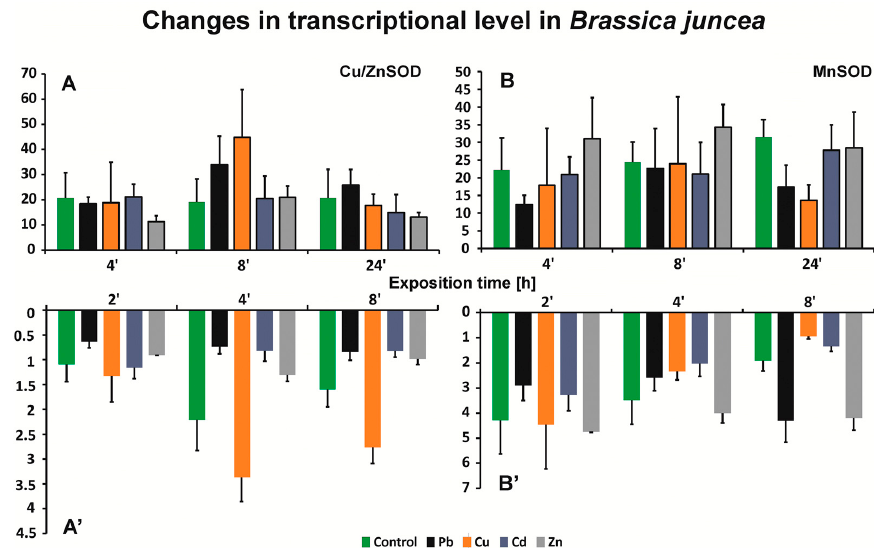
Figure 6. Transcriptional levels of genes encoding antioxidative enzymes in roots and